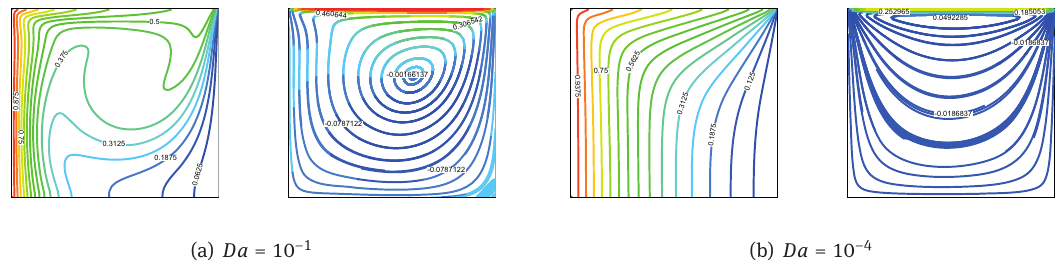
Fig. 6: Isotherms (left) and Streamlines (right) for different Darcy number with Ri = 1 , L H = 1, γ 2 = 3/6 , ϵ = 0.4 , and χ = 0.06 .